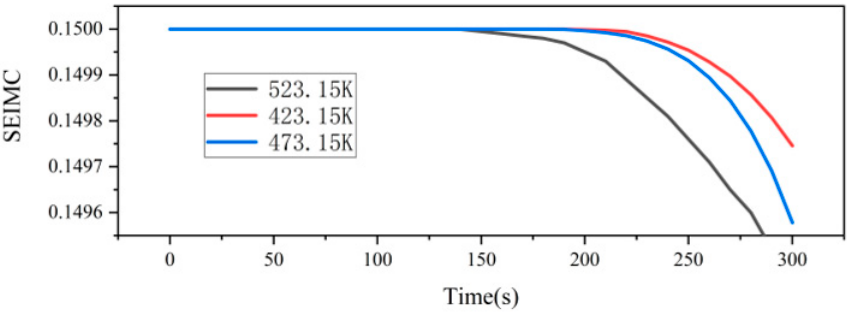
Figure 9. Conformational curves for changes in cell composition of the SEI films at different temperatures in tests 7, 8, and 9.